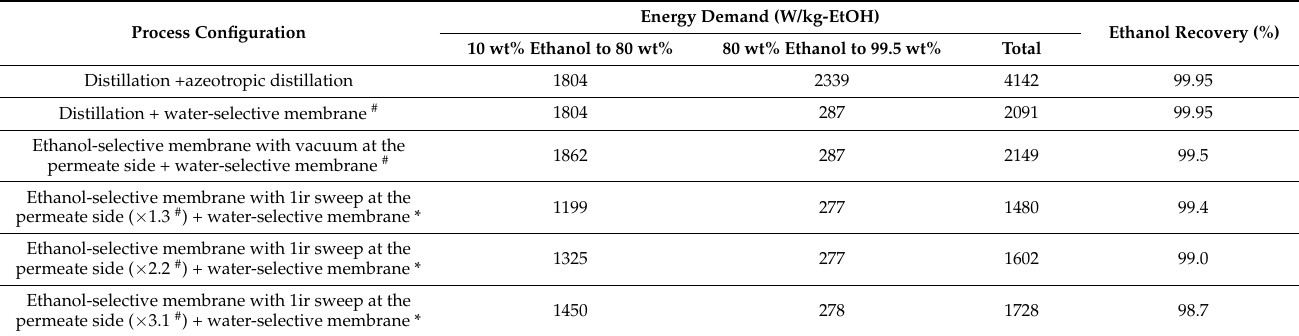
Table 4. Comparison of the energy demand to concentrate ethanol from 10 to 99.5